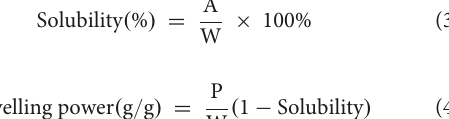
Phosphorous content ( % ) =